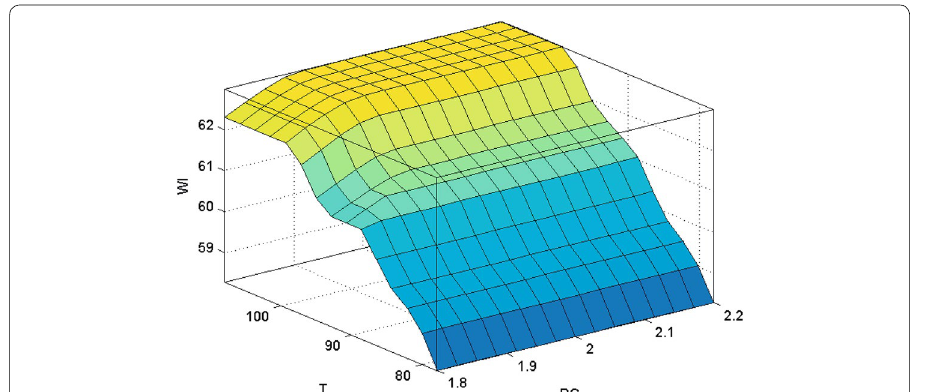
Fig. 7 Graphical operation of fuzzy logic model